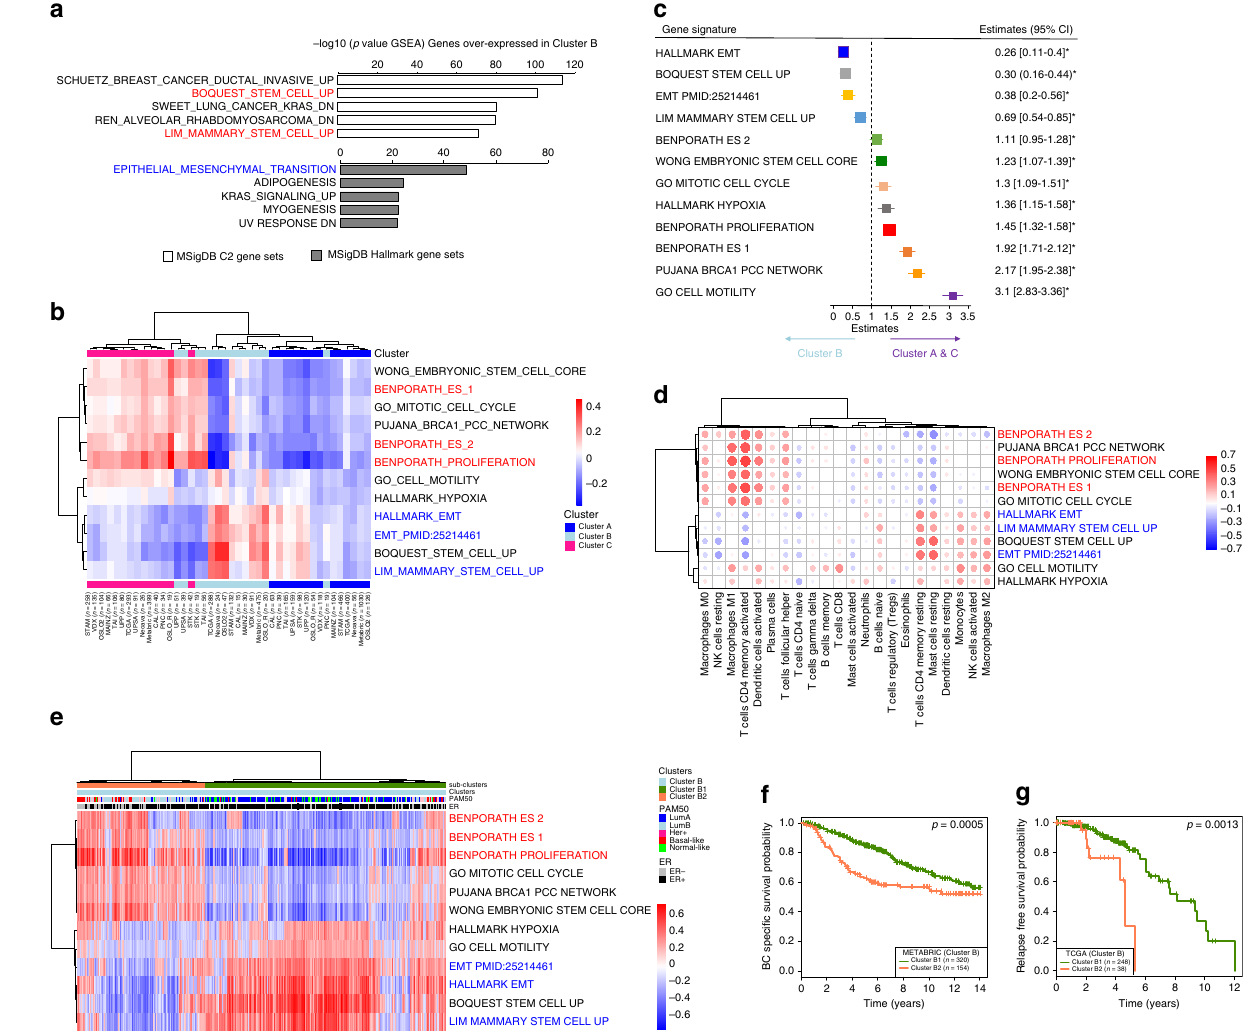
Fig. 6 Immune clusters are associated with EMT and proliferation, two mutually exclusive phenotypes in breast cancer. a Genes overexpressed in Cluster B were de fi ned using Bonferroni-corrected differential expression analysis (Cluster B vs Cluster A and Cluster B vs Cluster C). Genes with signi fi cantly higher expression in Cluster B were used in a gene set enrichment analysis using the C2 (white histograms) and H (gray histograms) collections of the MsigDB. − Log10 p value of hypergeometric test are presented. The fi ve most enriched processes in each collection are denoted. b Samples from each cohort (15 cohorts; 6101 samples) were scored using the GSVA Bioconductor package for enrichment in 12 pathways related to proliferation, EMT, and stem cells (Supplementary Data 3). Average enrichment scores are calculated per immune cluster and cohort. Unsupervised clustering using maximum method and ward. D2 linkage shows that pathways enrichment scores recapitulate the immune clusters. The numbers of samples in each cohort and immune clusters are denoted. Immune cluster from which the median score originate are annotated. c Estimates of univariate logistic regression analysis and the 95% con fi dence interval (CI) are illustrated by forest plot to assess which gene set signature scores calculated using GSVA associate with the poor prognosis cluster (Cluster B) vs Clusters A and C. Box size is inversely proportional to the width of the con fi dence interval. Asterisks denote FDR-corrected p value < 0.05. d Correlation plots represent all the signi fi cant (FDR p value < 0.05) Spearman correlations between gene set signature scores and inferred immune in fi ltration at the tumor site as calculated using the CIBERSORT algorithm. Color of the dots indicate positive (blue) or negative correlations (red). The size of the dots is proportional to the Spearman Rho value. e Unsupervised clustering of 1318 Cluster B samples from 15 cohorts according to the gene set signature scores using the correlation linkage and ward.D method allows to separate the samples in Cluster B with an EMT phenotype: Cluster B1 (green) or proliferative phenotype: Cluster B2 (orange). PAM50 subtypes and ER status are annotated on the top of the heatmap. f , g Kaplan – Meier survival curves for Cluster B1 (green) and Cluster B2 (orange). In all METABRIC ( b ) and TCGA ( c ) samples. p Values are from log-rank tests. Kaplan – Meier display breast cancer-speci fi c survival for the METABRIC and relapse-free survival for the